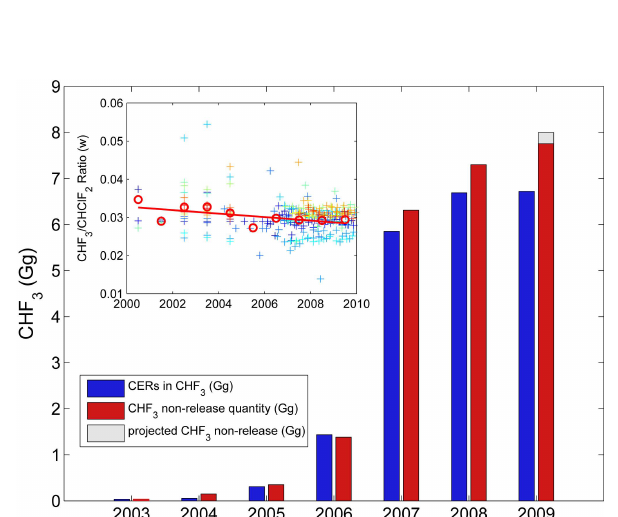
Fig. 4. Annual amounts of HFC-23 (CHF 3 ) involved in the Clean Development Mechanism (CDM) HFC-23 emission abate- ment projects. Registered projects number nineteen and consist of HCFC-22 (CHClF 2 ) production plants primarily in China and In- dia. These projects have produced Certified Emission Reduction (CER) credits amounting to a total of 208238 Ktonnes CO 2 equiv- alent (KtCO2eq) between 2003 and 2009 (shown as blue bars and converted to Gg of HFC-23). A more accurate estimate of the ac- tual annual quantities of HFC-23 that were prevented from emis- sion or “non-release quantities” (red bars) by the projects was de- termined by accounting for actual production, incineration, storage, sales and releases based on data from individual project monitor- ing reports. These actual annual estimates average ∼ 10% higher than those deduced from CERs alone. Thus, a total of about 23.53 Gg of HFC-23 was actually prevented from emission to the atmo- sphere during 2003 - 2009. This total includes an additional 0.24 Gg ( ∼ 3%) of HFC-23 projected to have been incinerated but not yet re- ported for 2009 (gray bar). The inset shows the HFC-23/HCFC-22 production ratios (“+”) from each CDM monitoring report from 17 projects. The annual mean ratios, weighted by production amounts, are shown as red